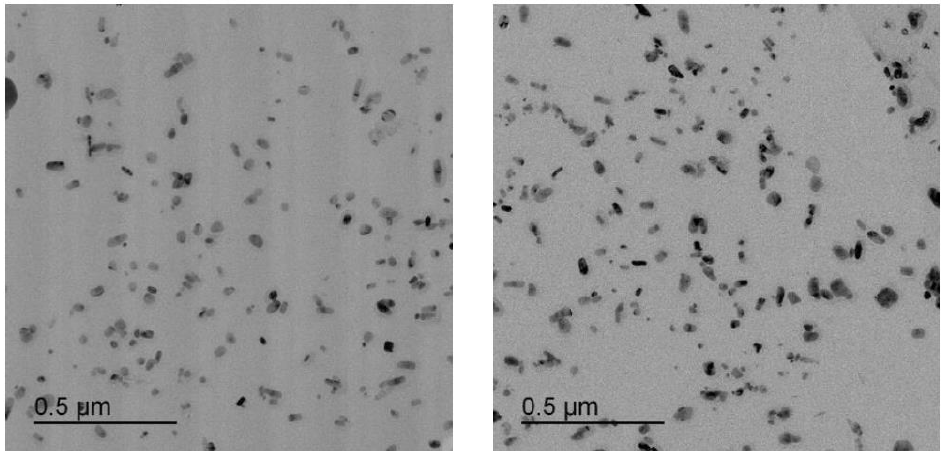
Figure 12. Failed crept cross-weld specimen 91-HAZ-3-8 650 °C 61 MPa 2072 h (sample D). TEM images on a carbon extraction replica at 100,000 X; MX, M 23 C 6 , and no Laves phases are noted.